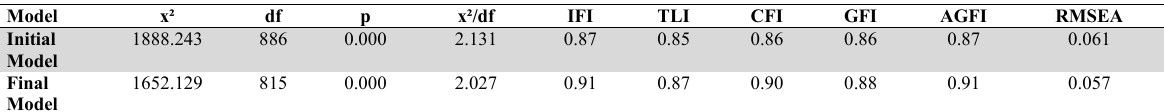
Measurement model fit indices Model